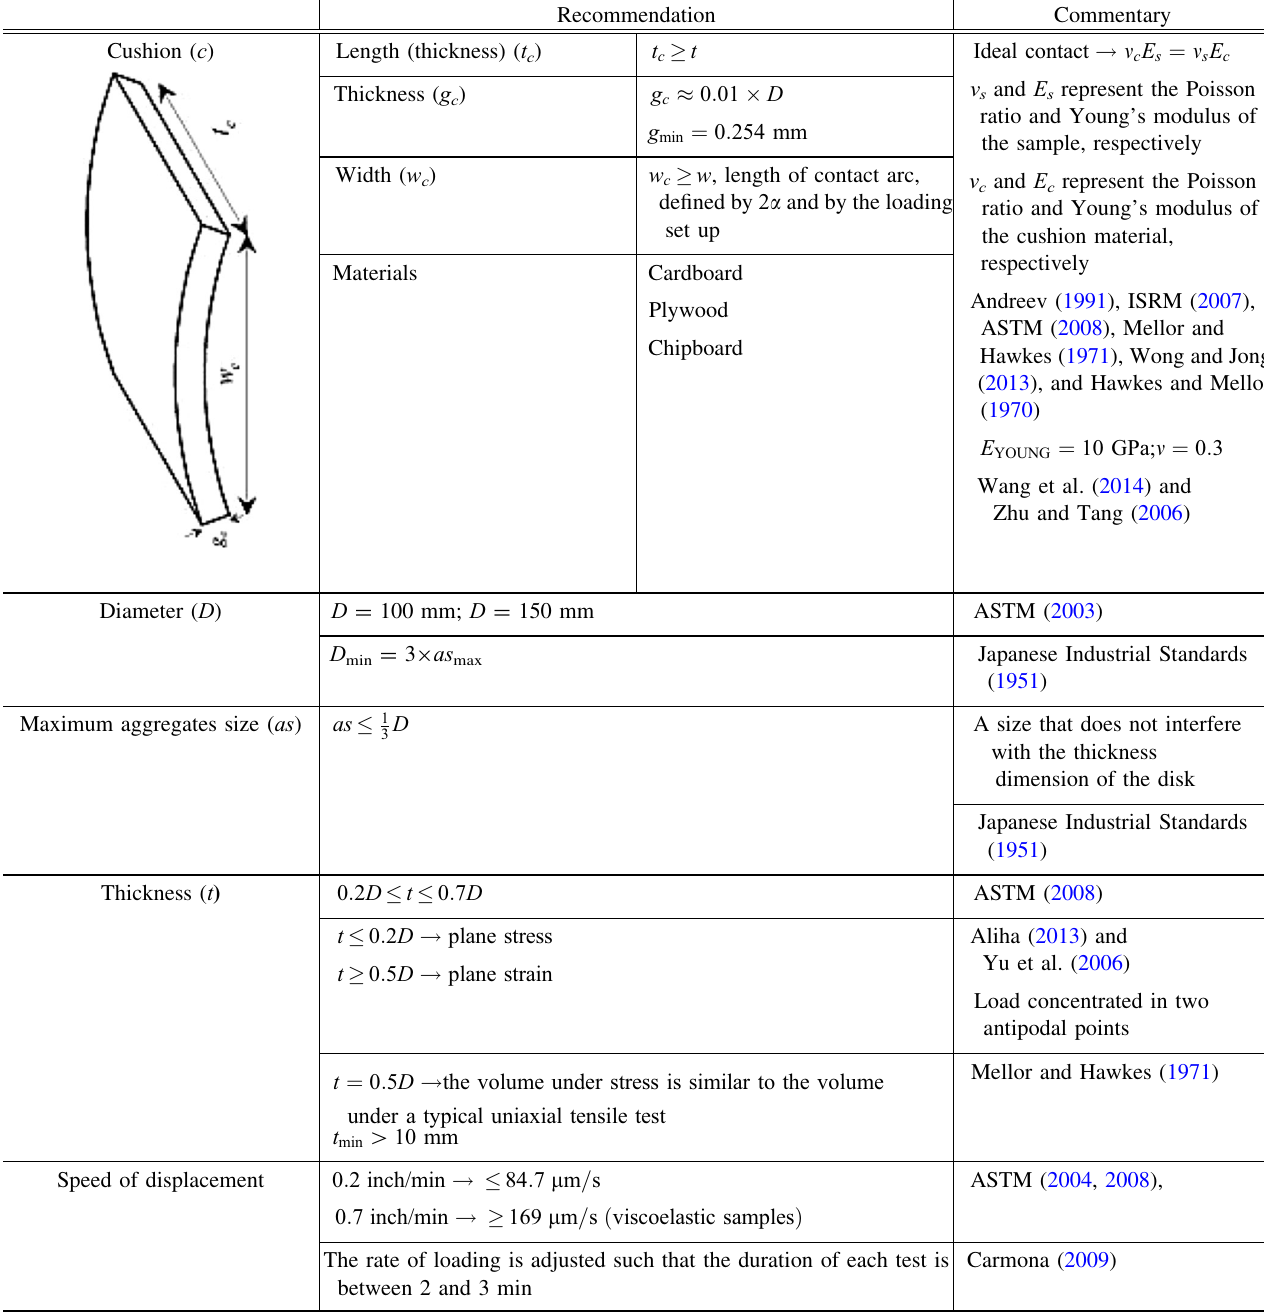
Table 3 A summary of the recommended practical considerations for mitigating the effect of stress concentration on the contact area, specimen diameter, and thickness, aggregates size, and load velocity on the Brazilian Test